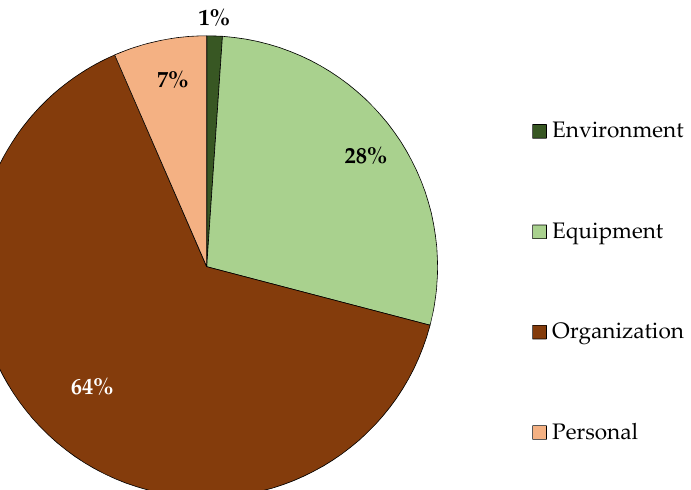
Figure 2. Health and safety related major and minor corrective actions required, and observations (n = 368) classified to four risk factor groups.